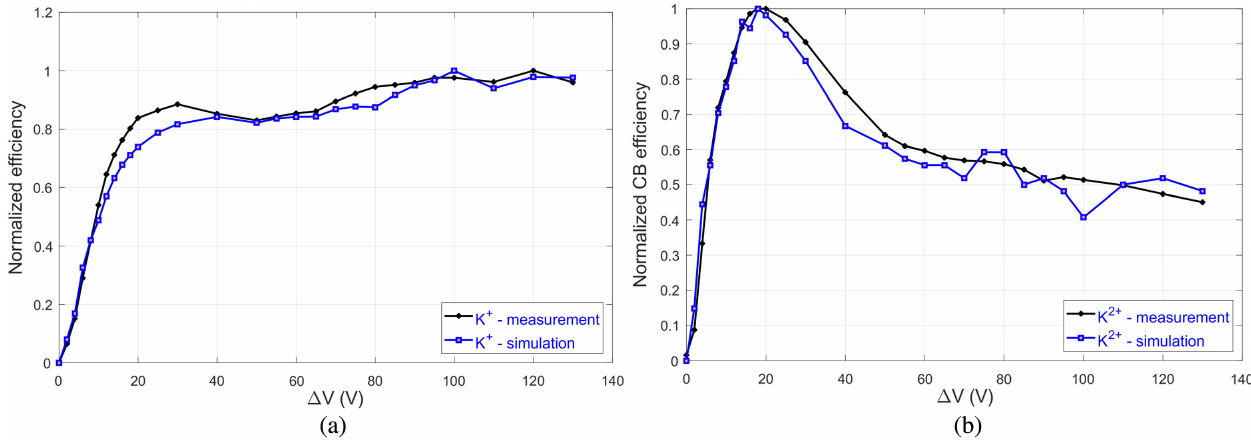
of 0.75 eV were used in the simulation. i